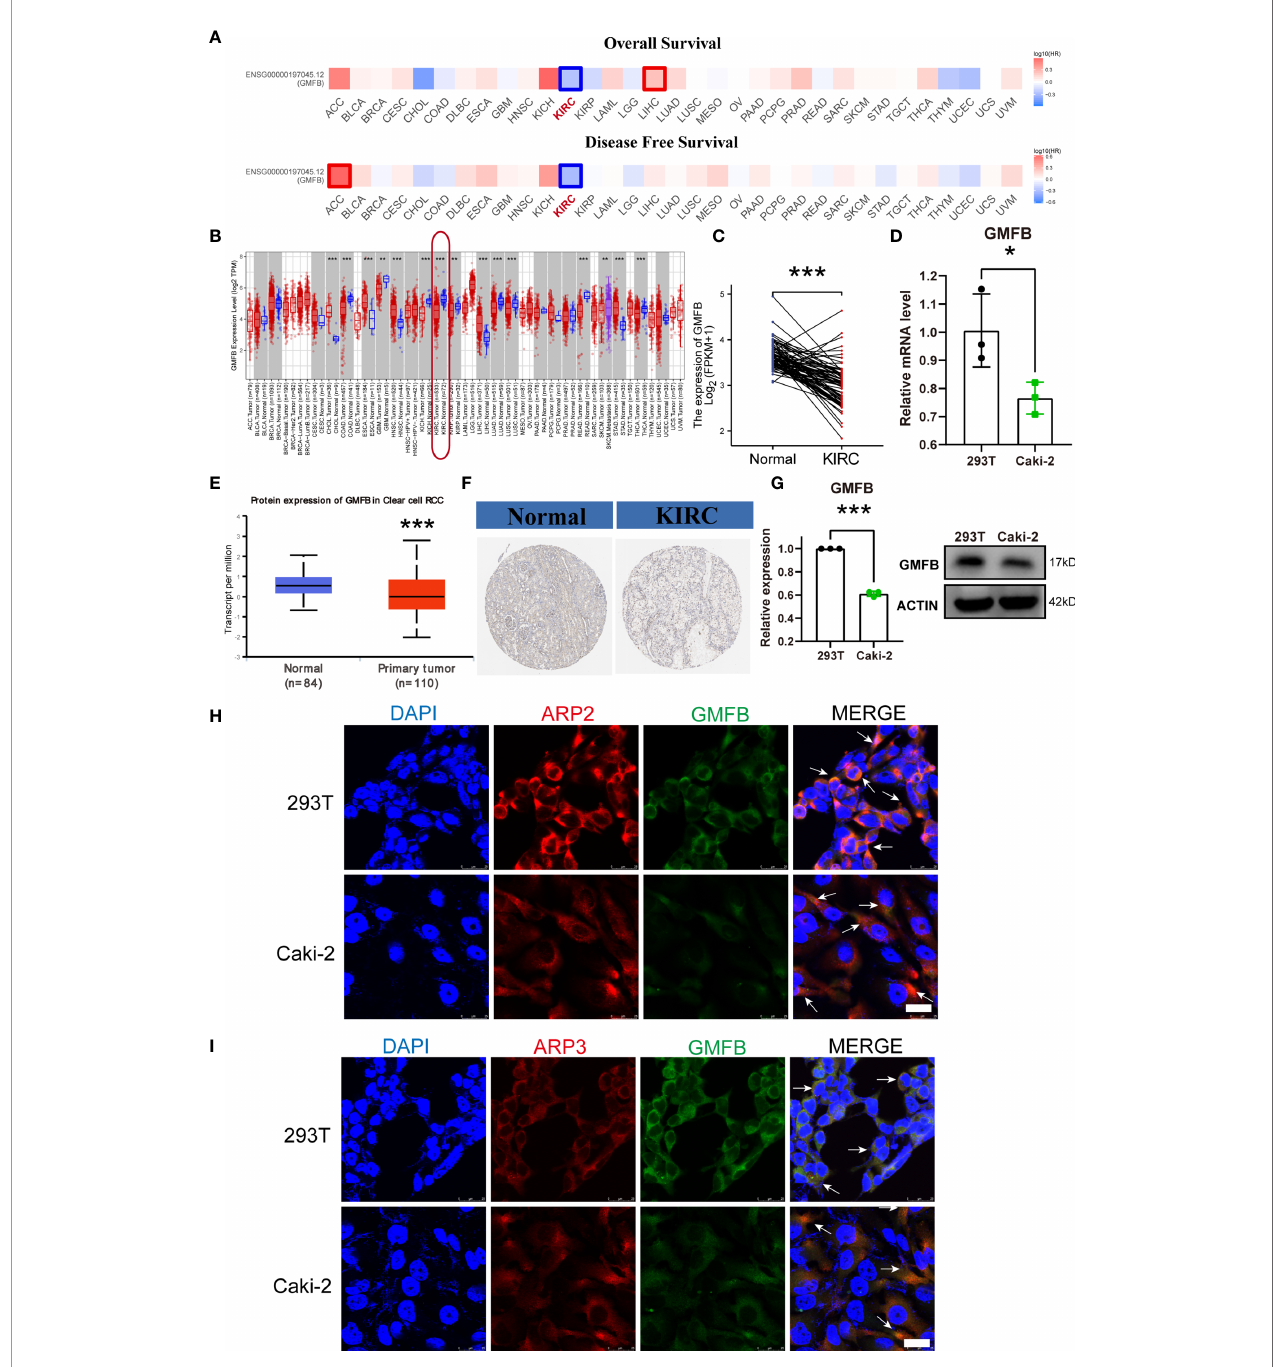
FIGURE 1 | Survival map and differential expression of the mRNA and protein level of GMFB in pan-cancer and KIRC. (A) Comparing the survival contribution of GMFB in pan-cancer, estimated using Mantel – Cox test, including overall survival (OS) and disease-free survival (DFS). Tumor types with signi fi cant differences (p-value adjustment <0.05) were highlighted. HR, hazard ratio. (B) Comparison expression of Gmfb mRNA level between tumor and normal tissues (pair samples). (C) Comparison expression of Gmfb mRNA level between tumor and normal tissues (unpaired samples). (D) Comparison expression of Gmfb mRNA level between HEK293T and Caki-2 cells tested by RT-qPCR. (E) Comparison of GMFB protein level expression between normal and KIRC tumor tissues (unpaired samples). (F) Immunohistochemistry images in normal and KIRC tumor tissues. (G) Comparison expression of GMFB protein level between 293T and Caki-2 cells tested by Western blotting. (H) Colocalization of GMFB with Arp2 in 293T and Caki-2 cells. (I) Colocalization of GMFB co-localized with Arp3 in 293T and Caki-2 cells. Scale bar = 25 m m. White arrows indicate co-location. KIRC, kidney renal clear cell carcinoma. Error bars represent SD. *p < 0.05, **p < 0.01, ***p <